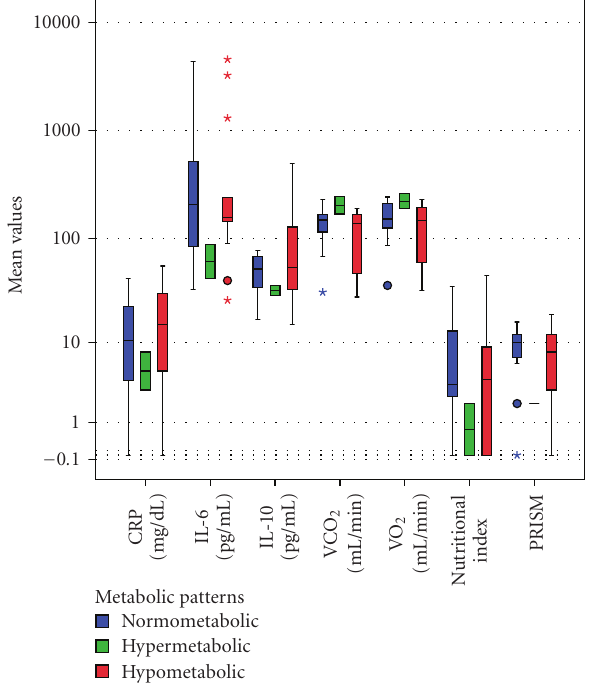
Figure 5: Only Oxygen consumption (VO 2 ) and carbon dioxide production (VCO 2 ) di ff ered significantly among metabolic patterns (ANOVA, Bonferroni post-hoc tests, P < . 0001). None of the cytokines and nutritional markers di ff ered between the metabolic patterns. Note the (nonsignificant) lower trend of the Pediatric Risk of Mortality Score (PRISM) and C-Reactive Protein (CRP) values in the hypermetabolic group of patients. The Box-whisker plots show the median (horizontal line within the box) and the 10th and 90th percentiles (whiskers). The box length is the interquartile range (logarithmic scale). Solid circles represent outliers, stars